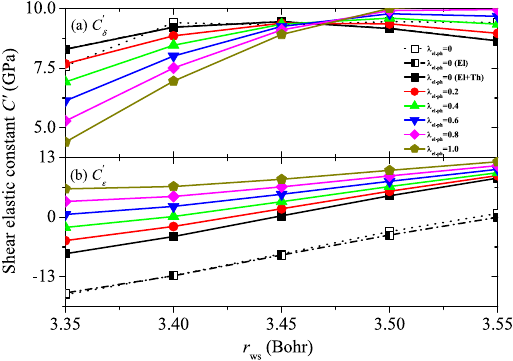
Figure 1. Static (0 K) tetragonal shear elastic constants C ′ of δ - and ε -Pu as a function of Wigner-Seitz radius (denoted as “ λ el-ph = 0”). Shown are also results corresponding to 750 K including only the electronic entropy term (denoted as “ λ el-ph = 0 (El)”), both the electronic entropy and lattice thermal expansion terms (denoted as “ λ el-ph = 0 (El + Th)”), and the electronic entropy, lattice thermal expansion, and electron-phonon coupling three effects (denoted as “ λ el-ph = . . … . 0 2, 0 4, , 1 0 ”).